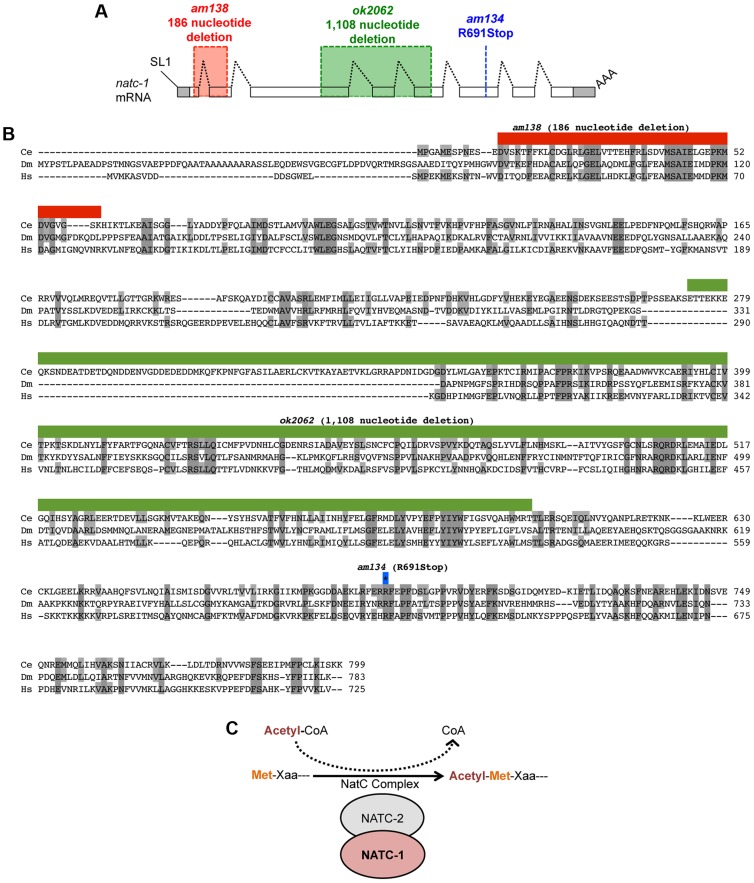

natc-1 encodes a subunit of the NatC protein acetylation complex.(A) The natc-1 mRNA structure. Boxes represent exons, and shading indicates untranslated regions. Black dotted lines indicate introns, SL1 (splice leader 1) indicates the 5′ trans-spliced leader sequence, and AAA indicates the 3′ polyA tail. am138 (red) and ok2062 (green) are deletion mutations, and am134 is a nonsense mutation at codon 691 (blue). (B) The predicted C. elegans NATC-1 protein is aligned with homologous proteins CG4065 from the insect Drosophila melanogaster (Dm) and NAA35 from the vertebrate Homo sapiens (Hs) [45]. Shaded amino acids are identical to C. elegans NATC-1. Amino acids deleted by am138 (red) and ok2062 (green) are shown above. The blue-outlined asterisk indicates the codon mutated in am134. (C) A model based on the observations that NATC-1 and C. elegans NATC-2 (B0238.10) are homologous to an auxiliary and catalytic subunit of the NatC complex, respectively. The NatC complex catalyzes the acetylation of translating proteins at the N-terminus utilizing acetyl-CoA as a substrate. Xaa following Met is typically isoleucine, leucine, tryptophan, or phenylalanine [39], [40].